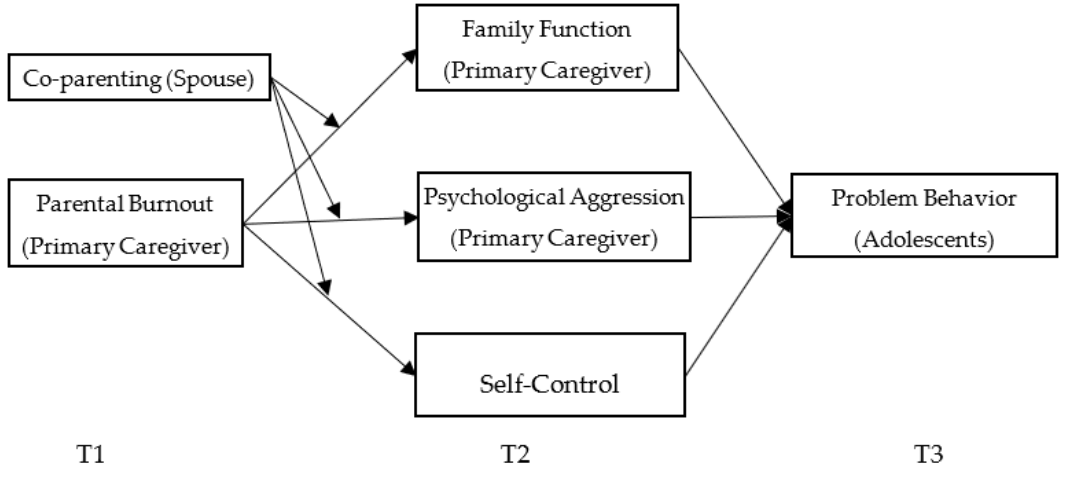
Figure 1. The basic framework of this study.